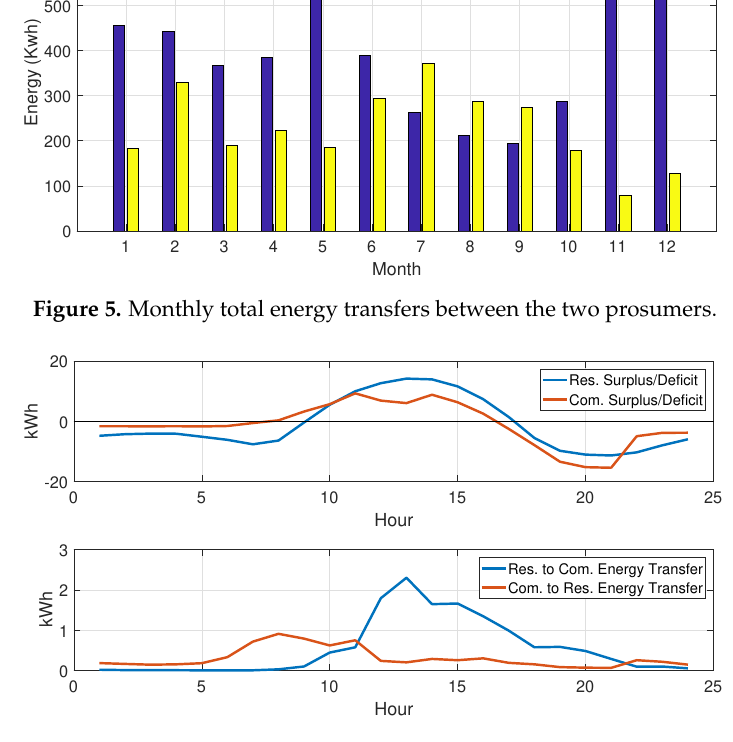
Figure 6. Average daily energy transfers between the two